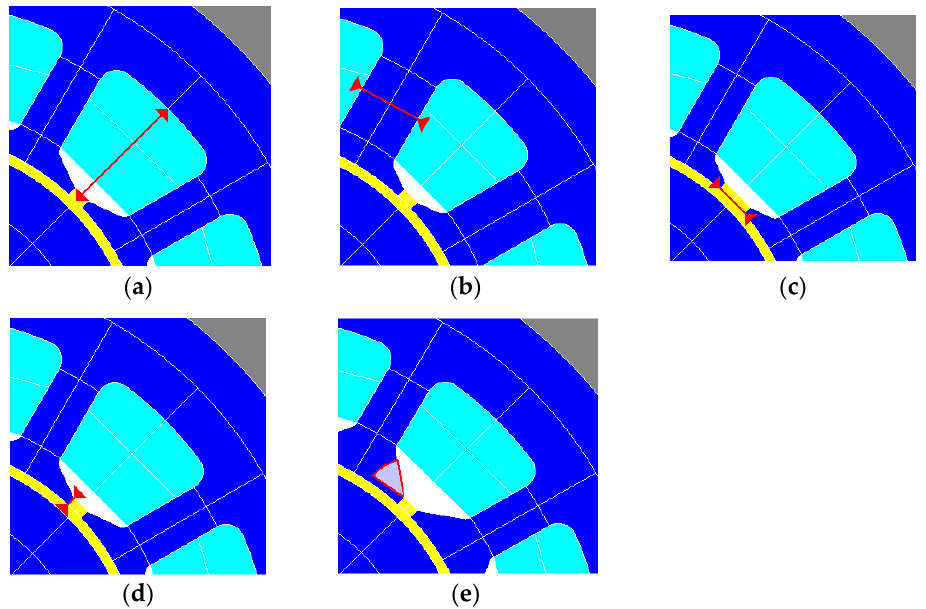
Figure 11. Selection factors for stator core design optimization: ( a ) slot depth; ( b ) stator tooth width; ( c ) slot opening; ( d ) radial depth; ( e ) undercut angle. Table 3. Factors of fractional factorial design and results. Factor Result